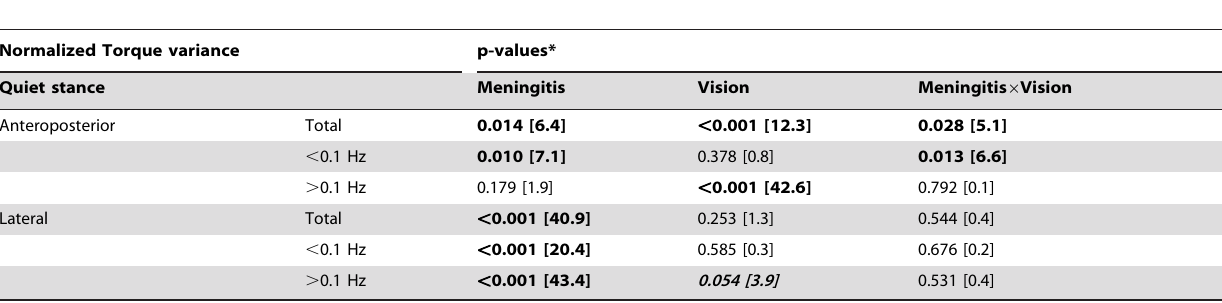
Table 1. Statistical evaluation of anthropometrical height and mass normalized torque variance values during quiet stance, comparing subjects treated in childhood for meningitis with healthy